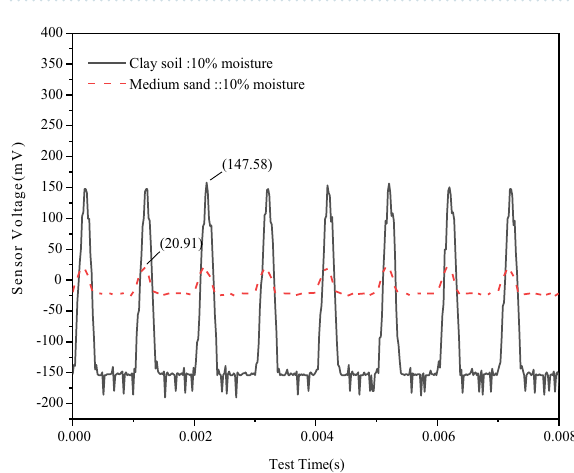
Figure 7. Sensing voltage changes of the two samples with different moisture content; ( a ) Sensing voltage variation diagram of clay samples with different moisture content; ( b ) Changes in the induced voltage diagram of sand samples with different moisture content.